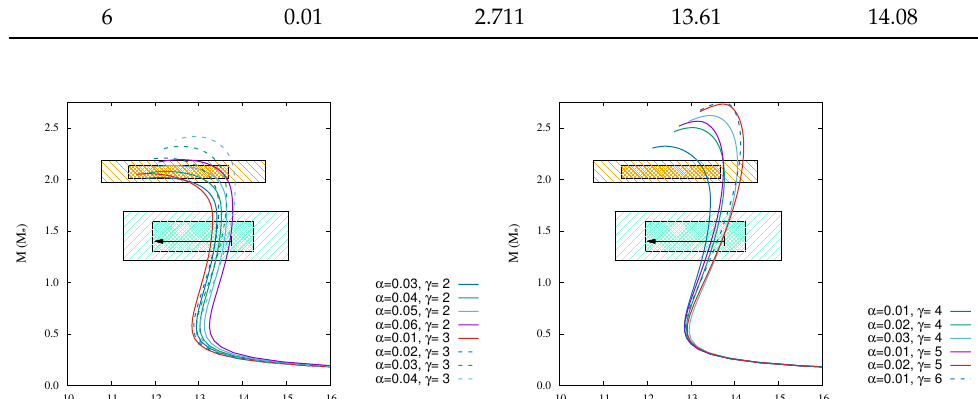
Figure 9. MR relations of TM2 ωρ -b EoS with magnetic fields. The strength of surface magnetic field strength B s is 10 12 G, and the central magnetic field strength B 0 is 2.5 × 10 18 G. The arrow and colored hatched areas are the same as in Figure 1. Table 10. Maximum mass ( M max ) in unit of M (cid:12) and radius (km) at M = 1.4 M (cid:12) ( R 1.4 M radius (km) at M = 2.072 M (cid:12) ( R 2.072 M ) for TM2 ωρ -b EoS with magnetic fields ( B s = 10 12 G, (cid:12) B 0 = 2.5 × 10 18 G)